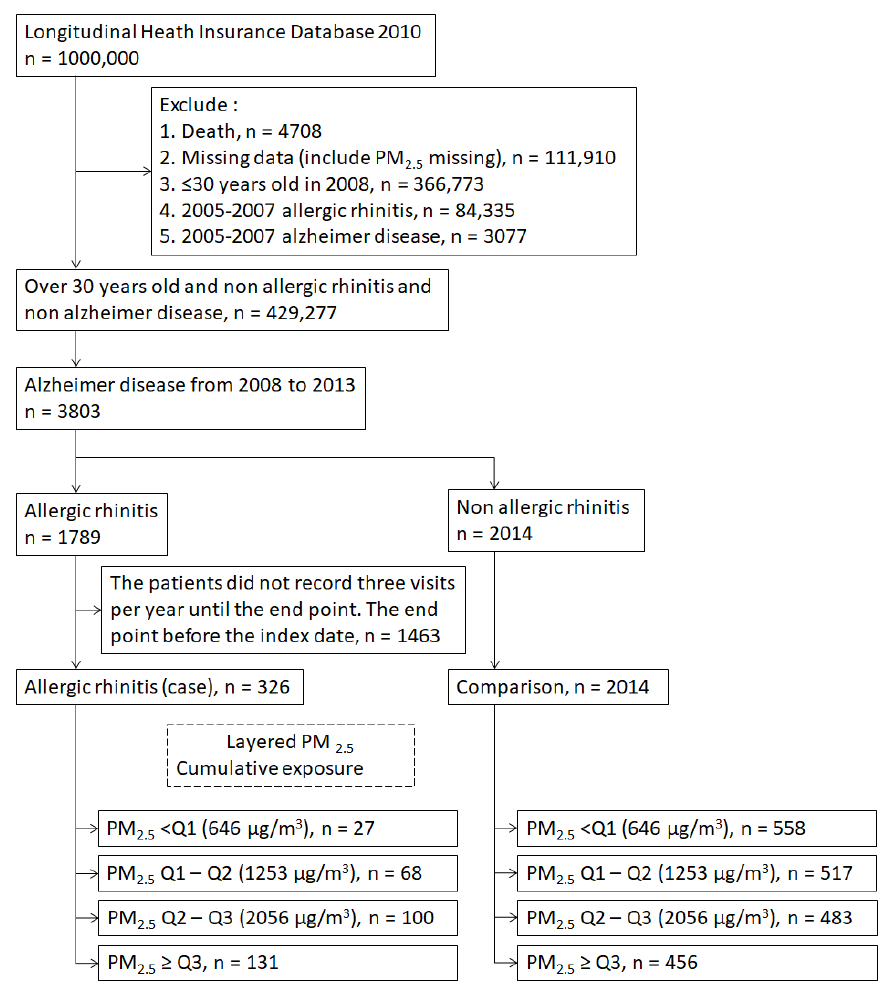
Figure 1. Flow chart of the cohort study.